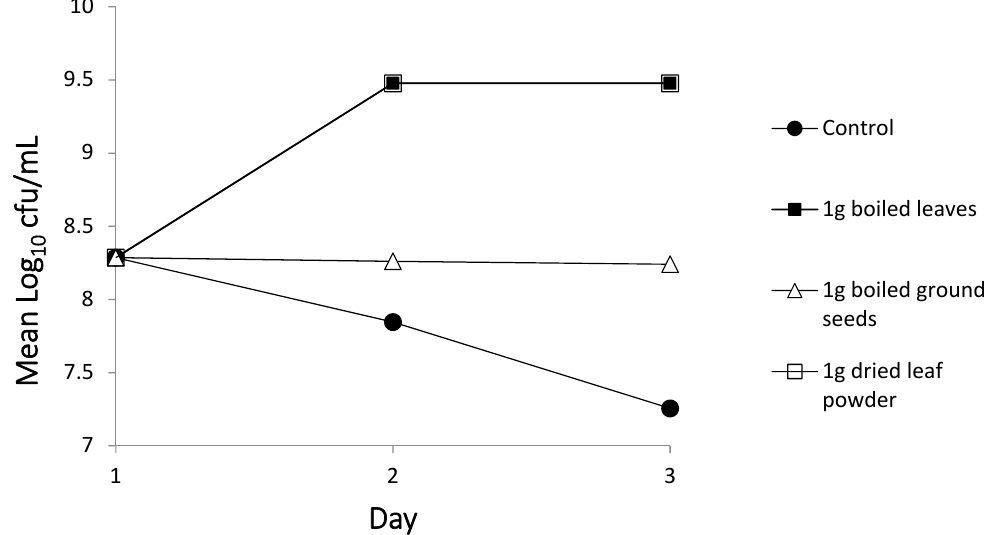
Figure 2. Mean log 10 cfu/mL of E. faecalis in bottles containing different preparations of M. oleifera compared to Controls, Days 1–3.